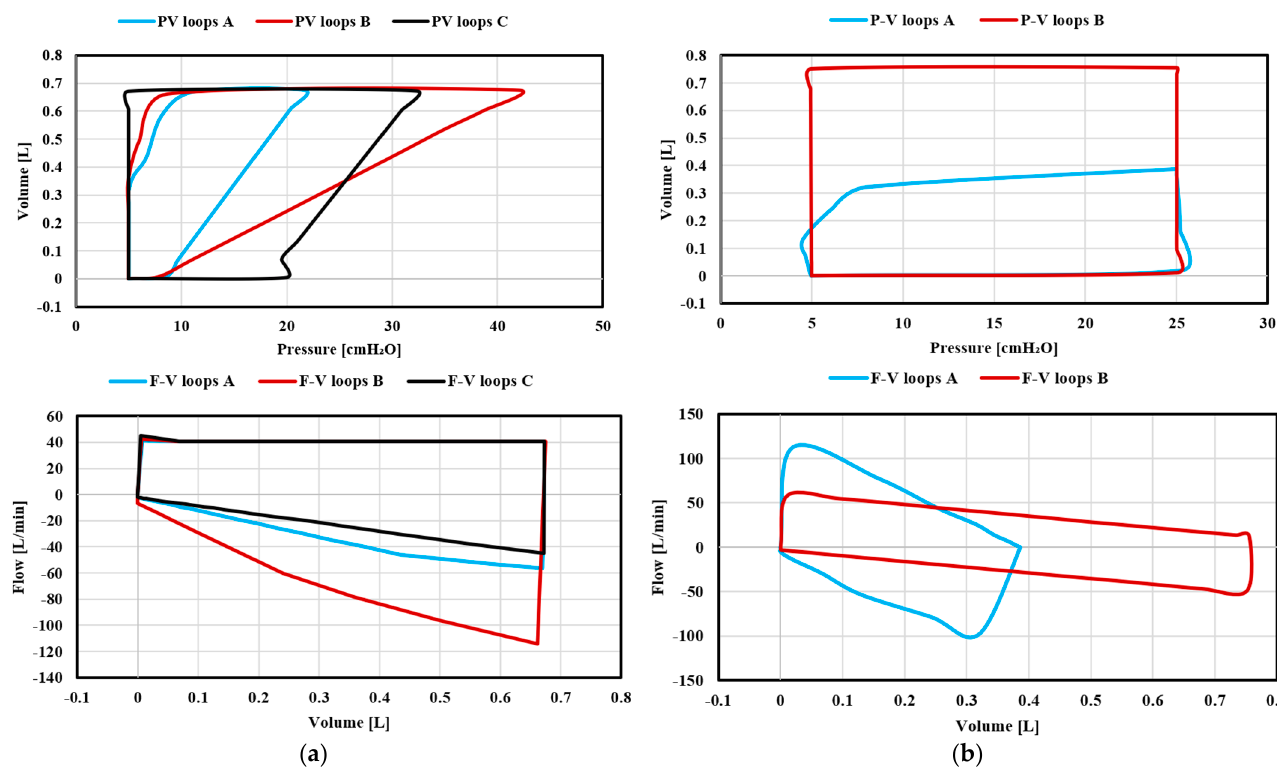
Figure 28. Case 3. Simulation results of P–V loops and F–V loops: ( a ) VC-CMV mode; ( b ) PC-CMV mode.